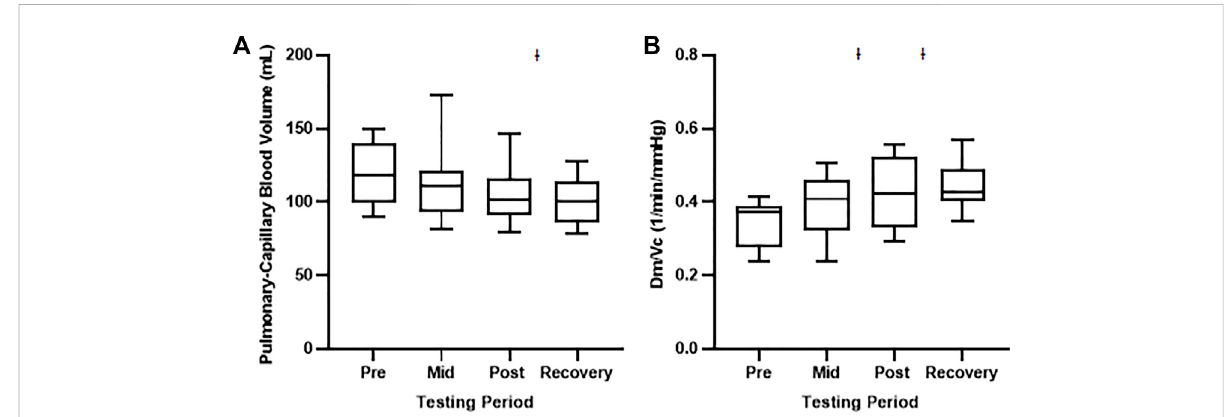
FIGURE 2 Pulmonary-capillarybloodvolumeandtheratiobetweenmembranediffusioncapacityandpulmonary-capillarybloodvolumeduringthe120 s oscillation exposure. Values represent means ± SD. (A) Depicts pulmonary-capillary blood volume and (B) Depicts Dm/Vc ratio. Ɨ Signi fi cant difference from the Pretesting period, p < 0.01.